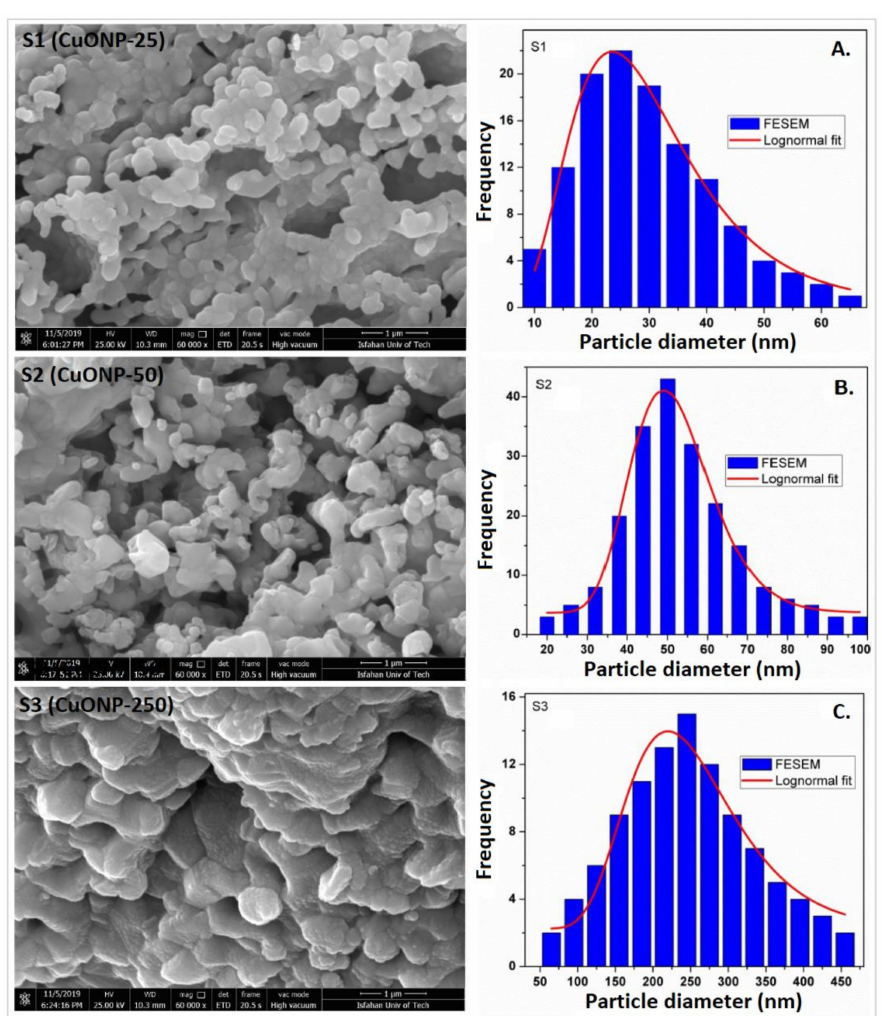
Figure 1. Electron micrographs (FE-SEM) of three di ff erent size CuONPs with particle size distribution (PSD): ( A ) S1 showing an average diameter of 25 nm, denoted CuONP–25; ( B ) S2 showing an average diameter of 50 nm, denoted CuONP–50; ( C ) S3 showing an average diameter of 250 nm, denoted